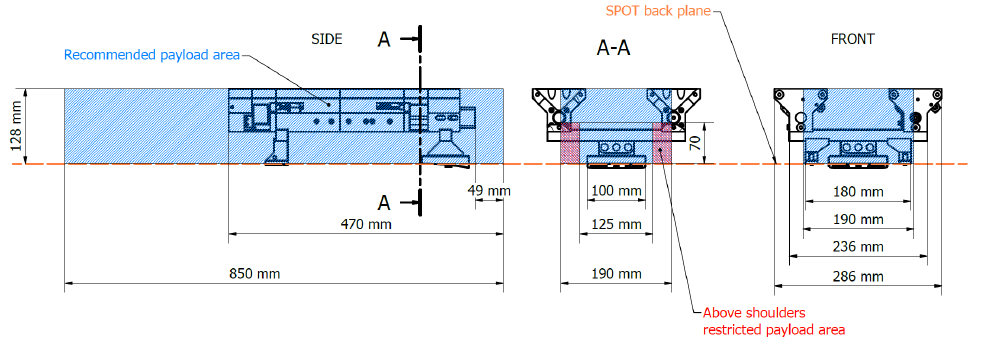
Figure 6. The dimensions of the landing platform relative to the recommended payload areas.